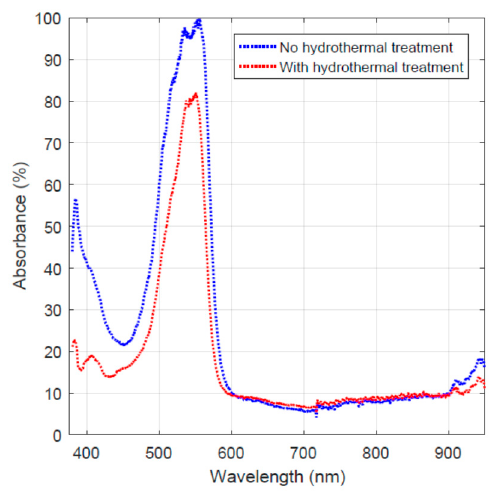
Figure 5. Light absorption of the remaining dye on day 16 for the two fiber specimens.